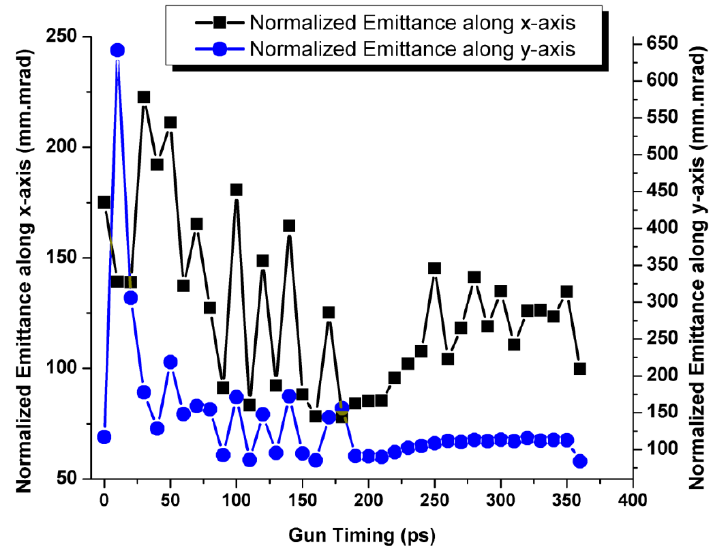
Figure 10. Variations in the x and y normalized emittance as a function of the gun timing.